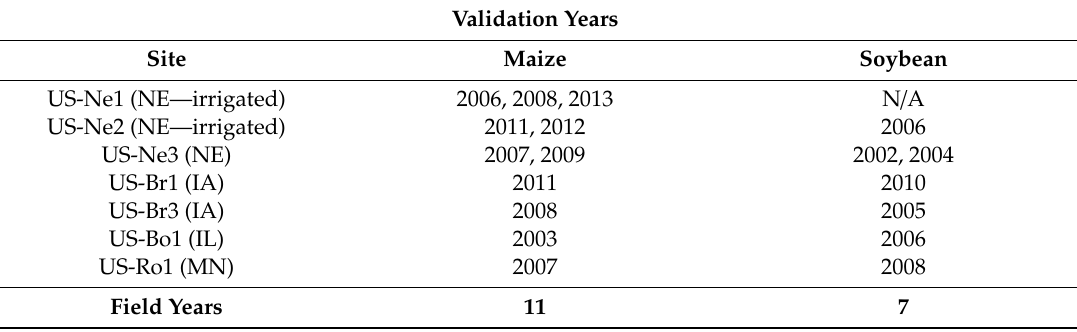
Table 3. AmeriFlux validation field